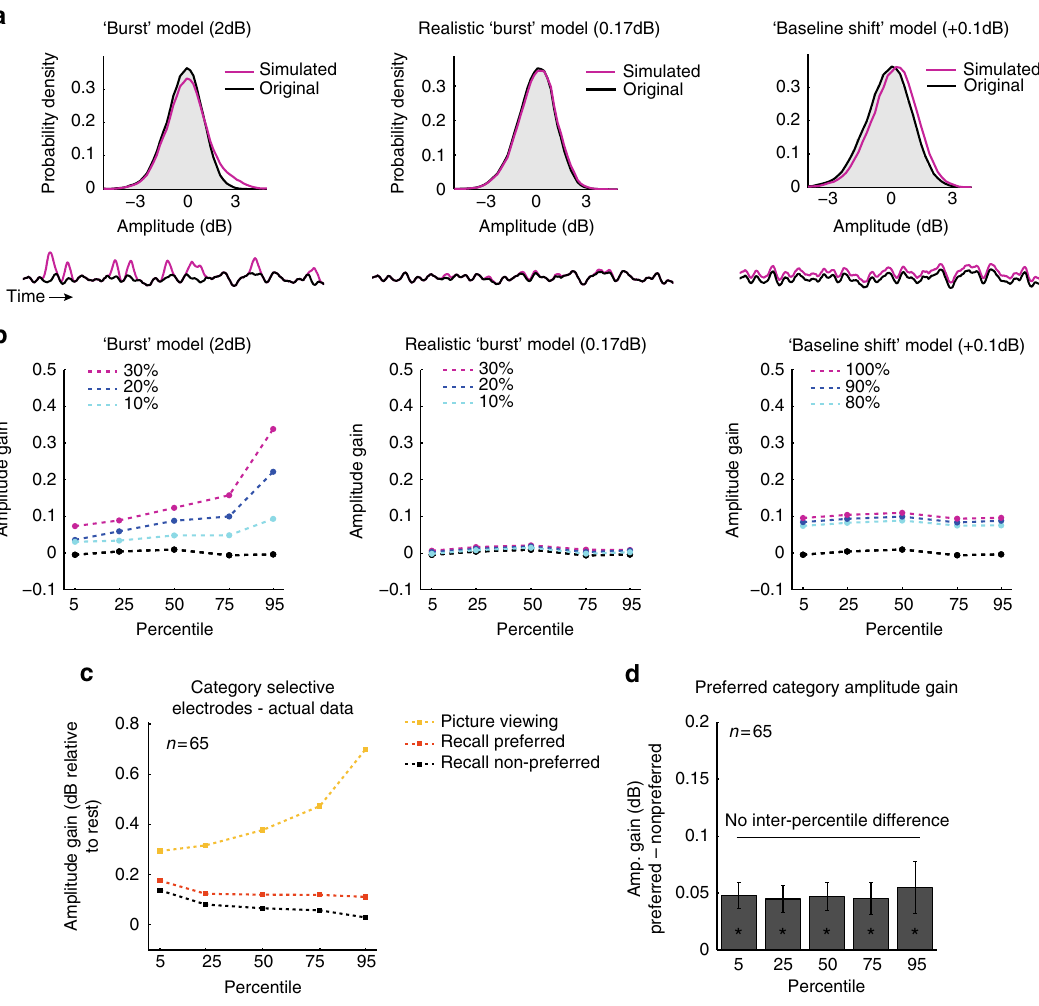
Fig. 4 Amplitude increase during retrieval re fl ects baseline-shift rather than transient bursts. a Top: an example log-normal distribution of HFB amplitude values in a representative face-selective electrode during retrieval of the non-preferred category (black). Magenta lines illustrate distributions of simulated signals (shown below) that represent the three main alternatives for the underlying process: ‘ burst ’ model — in which we arti fi cially inserted sporadic bursts of 2 dB (convolved with a 3 s Gaussian window) to 10% (light blue) 20% (blue) and 30% (magenta) of the signal to simulate a clear case of burst dynamics; a more realistic “ burst ” model in which we arti fi cially inserted sporadic bursts of 0.17 dB to 10, 20, or 30% of the signal to simulate recall-related activations similar to the response during individual recall events reported in Fig. 5; and fi nally, a ‘ baseline shift ’ model, in which we added a constant gain of 0.1 dB to 80, 90, or 100% of the signal. b Differences between the three models are evident when comparing amplitude changes across percentiles. As can be seen, only the ‘ baseline-shift ’ model leads to a constant gain across all percentiles. c , d In the actual data, category selective electrodes manifest statistical properties that are more compatible with the baseline-shift model: a signi fi cant amplitude gain across all percentiles during recall of the preferred category (* p < 0.001, preferred minus non-preferred category, signed-rank test), with no signi fi cant inter-percentile differences ( p > 0.84, Kruskal − Wallis test). For comparison, during stimuli presentation the same electrodes show an amplitude modulation more compatible with a “ burst ” model rather than baseline-shifts, as expected when presenting transient stimuli (yellow). Error bars represent